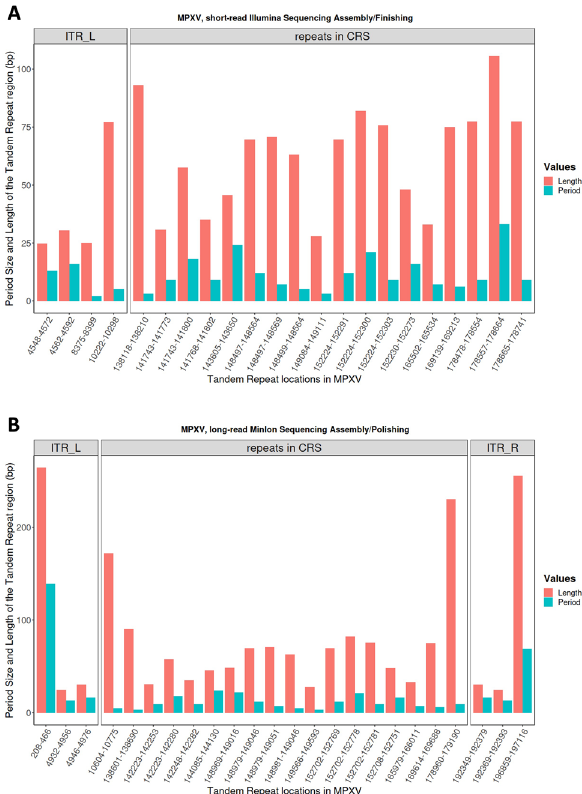
Figure 4. Tandem repeat locations in monkeypox virus genome for short-reads Illumina ( A ) and long-reads MinION ( B ) sequenced genomes using Tander Repeat Finder